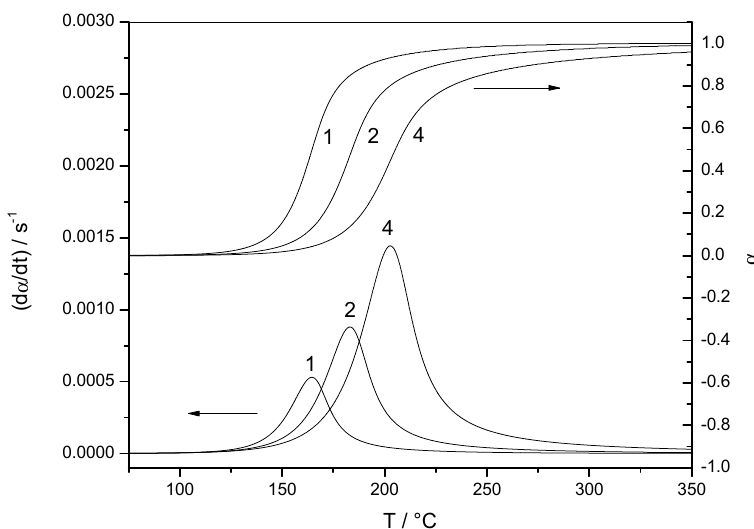
Figure 2. Non-isothermal data. Variation of the reaction rate (d α /d t ) and the extent of conversion ( α ) with temperature ( T ) for data set 1. The heating rate of each experiment (in K min − 1 ) is indicated by each curve.